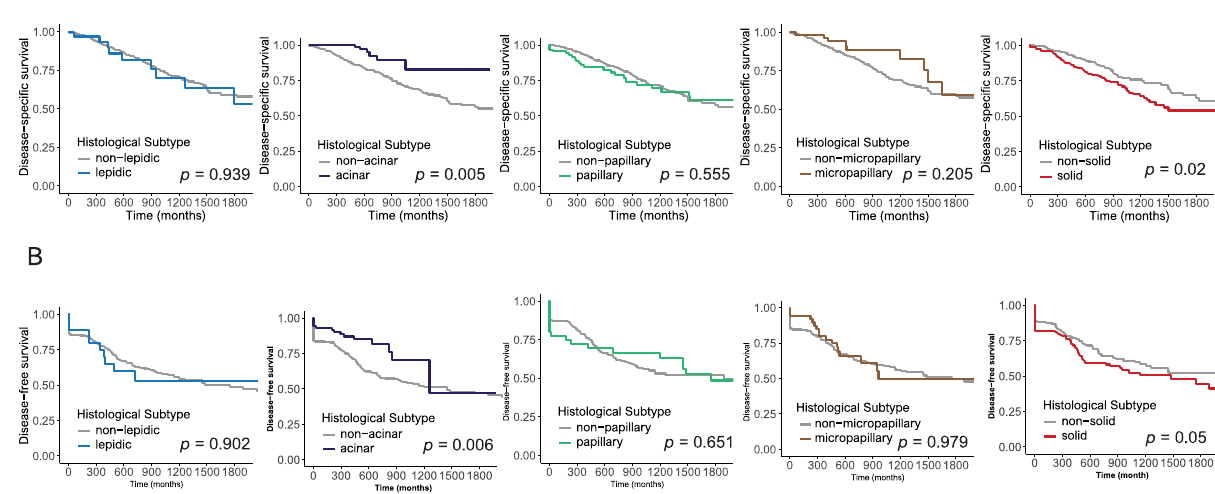
Figure 2. Survival analyses of the five types. ( A ) Disease-specific survival: lepidic, acinar, papillary, micropapillary and solid types ( p = 0.939, 0.005, 0.555, 0.205 and 0.02, respectively). ( B ) Disease-free survival: lepidic, acinar, papillary, micropapillary and solid types ( p = 0.902, 0.006, 0.651, 0.979 and 0.05,